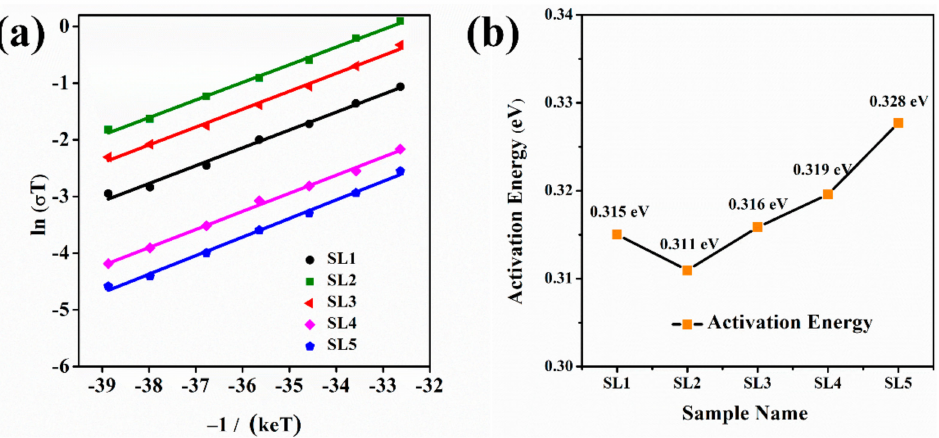
Figure 5. ( a ) Arrhenius plots and fitting results and ( b ) the activation energy of di ff erent LLZNO